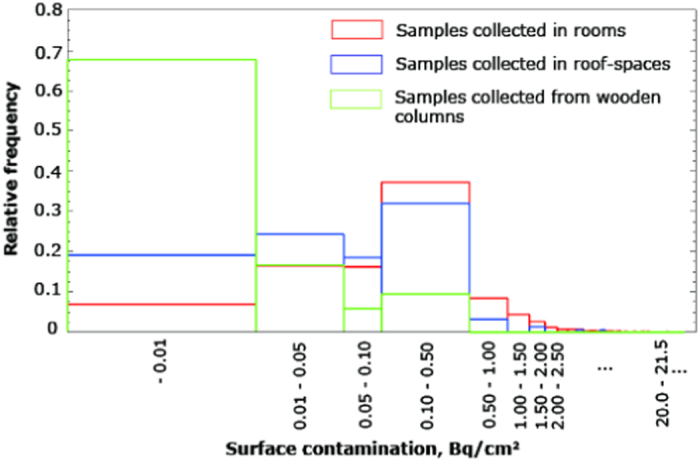
Relative frequency distribution of surface contamination for samples collected in rooms, roof-spaces, and from wooden columns in rooms.It covers all 1,662 samples collected in Odaka district, Okuma and Futaba, and Tomioka.